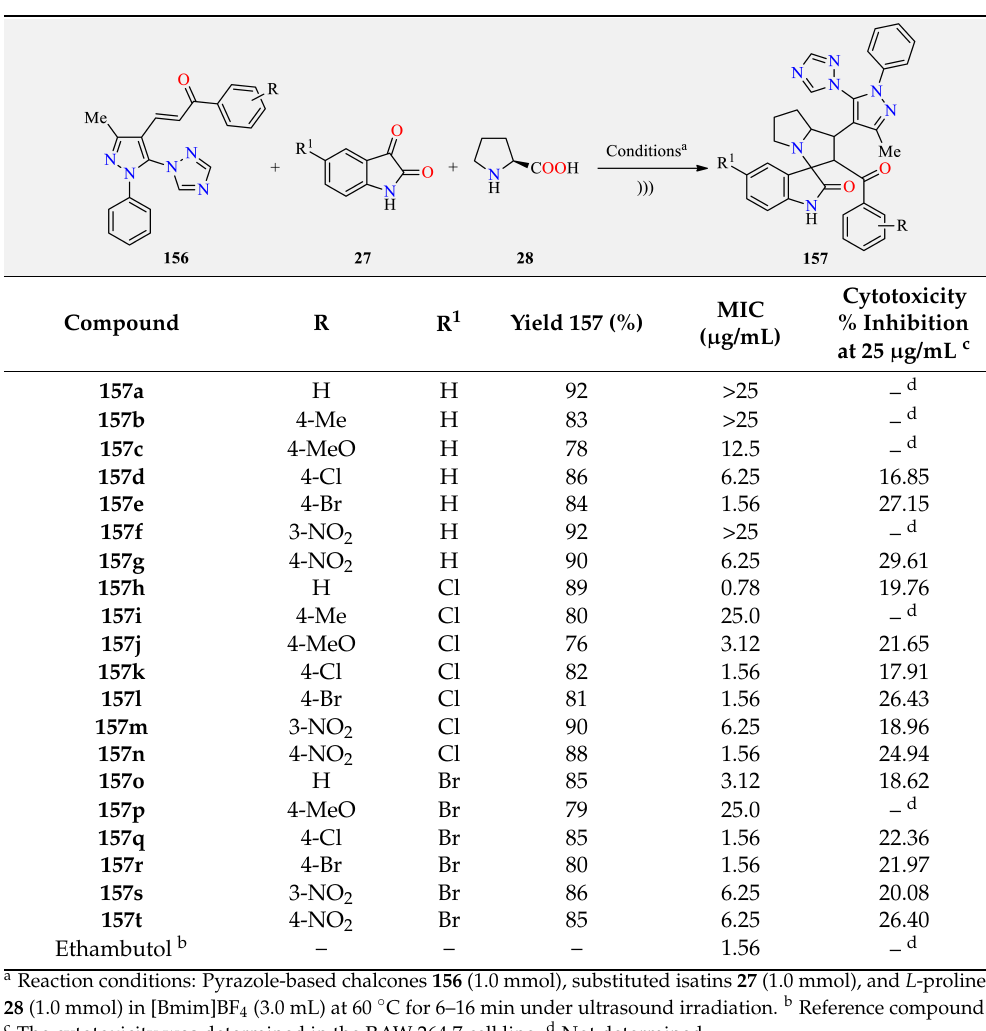
Table 51. Ultrasound-assisted three-component synthesis of 1,2,4-triazol-1-yl-pyrazole-based spirooxindolopyrrolizidines 157 as antitubercular